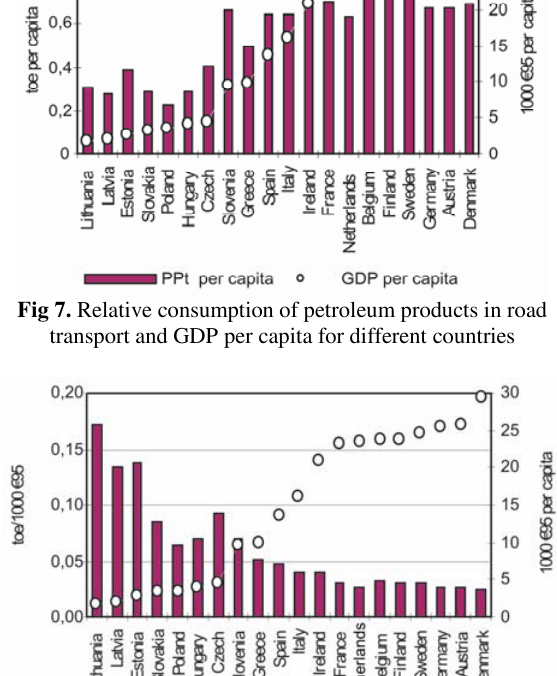
y = 0,2853x -0,5095